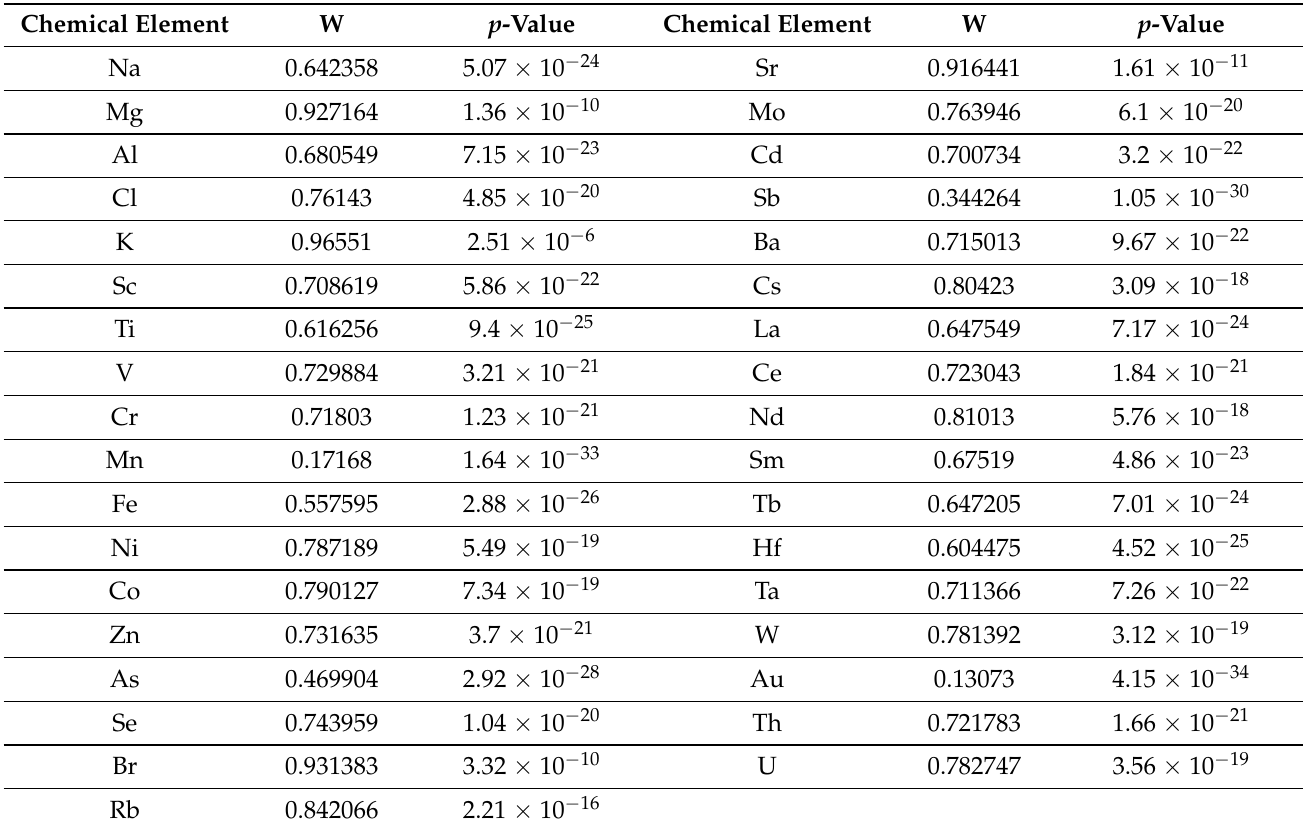
Table 4. Results of the Shapiro–Wilk test for